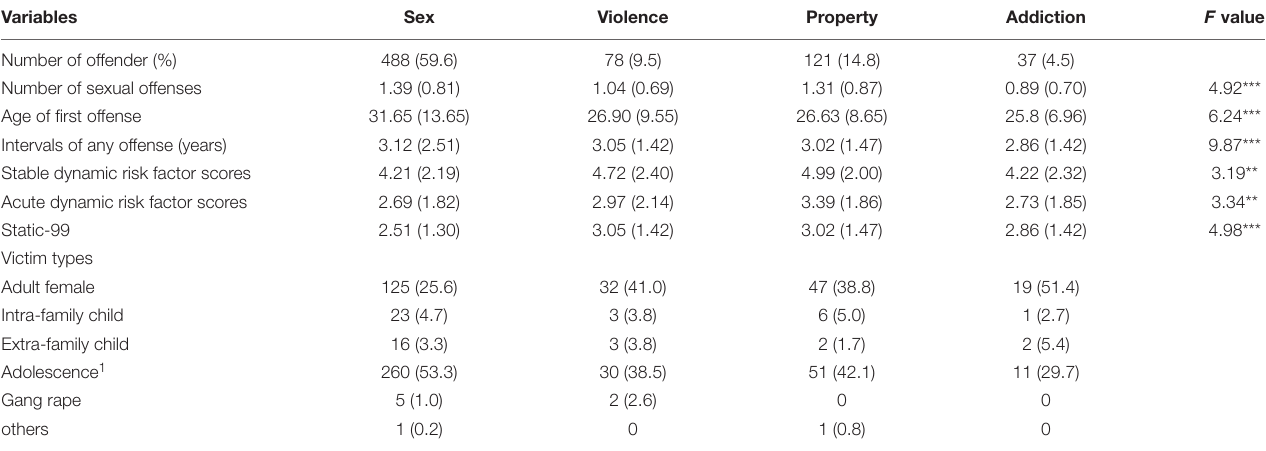
TABLE 2 | One-way ANOVA of different onset typology